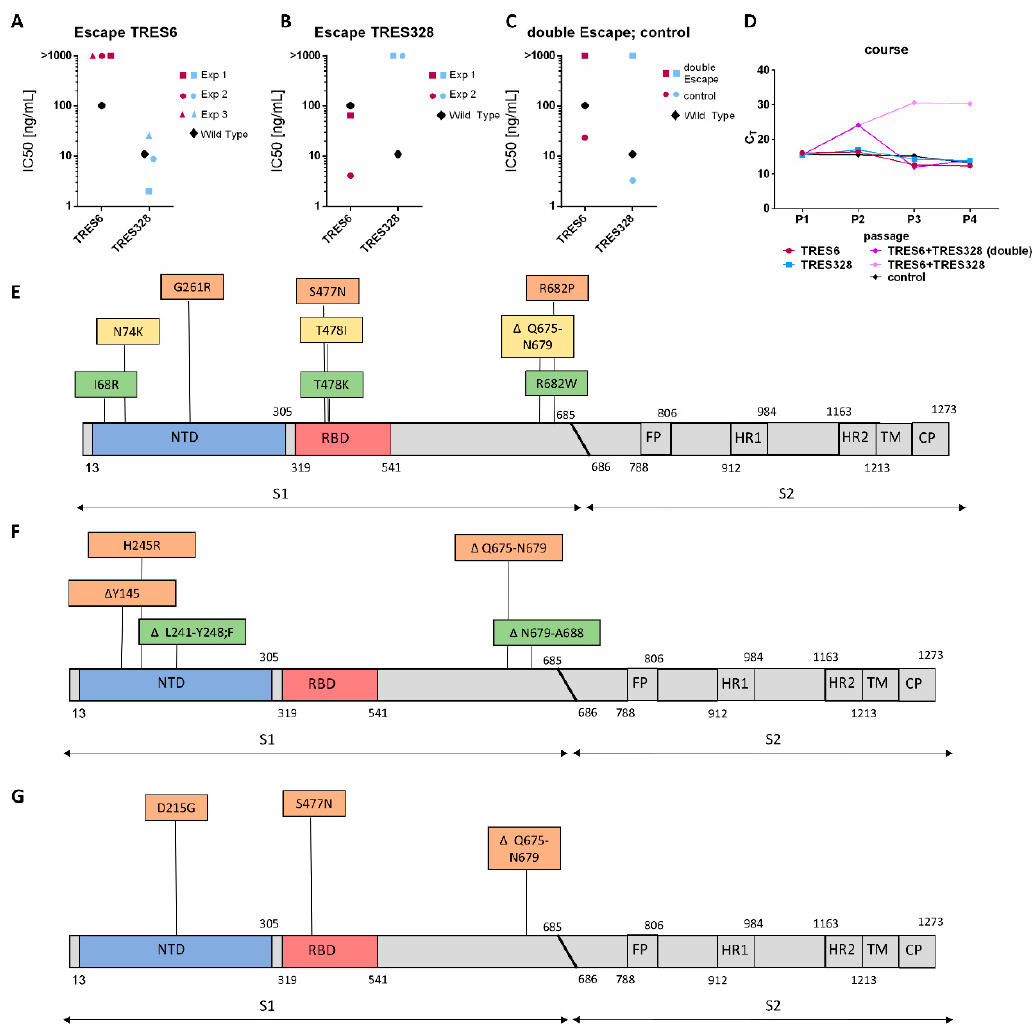
Figure 1. Neutralization of escape variants and identification of mutations. ( A ) IC50s of the antibodies indicated for the TRES 6 escape variants selected in three independent experiments (Exp) and the wild type virus. IC50s were taken from [27]; ( B ) IC50s of the antibodies indicated for TRES328 escape variants selected in two independent experiments and the wild type virus; ( C ) IC50s of the antibodies indicated for an escape mutant selected in the presence of TRES6 and TRES328 and without antibody and the wild type viral isolate; ( D ) viral load (C T ) in cell culture supernatants of the indicated passages and antibodies used for selection. Double the inoculation volume was needed to maintain sufficient viral load levels during passaging in the presence of TRES6 and TRES328. ( E – G ) Mutations identified through amplicon sequencing of the TRES6 ( E ), TRES328 ( F ), and TRES6+TRES328 ( G ) viral escape variants. Mutations identified in the first isolate are displayed in yellow, in the second isolate in green, and the third isolate in orange. Map not drawn to scale. FP: fusion peptide; HR: heptad repeat; TM: transmembrane domain; CP: cytoplasmic domain.